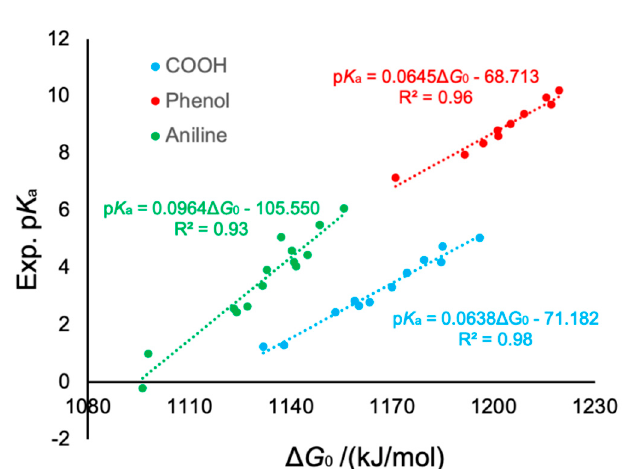
Figure 2. Example of linear fitting at B3LYP/6-31++G(d, p) + PCM-SMD level. Three chemical groups (COOH, phenol, and aniline) were considered. R 2 is the coefficient of determination. (cid:0) (cid:1) The G solv H + for the COOH, OH (phenol), and NH 2 (aniline) groups are 1115.71, 1065.32, and 1094.92 kJ/mol, respectively. This result indicates that, if one adopts the (cid:0) (cid:1) same G solv H + value for evaluating the p K a values of these compounds, a large error is obtained when using Equation (2). The AKB scheme complements the errors arising from both a difference in the method and the chemical groups,